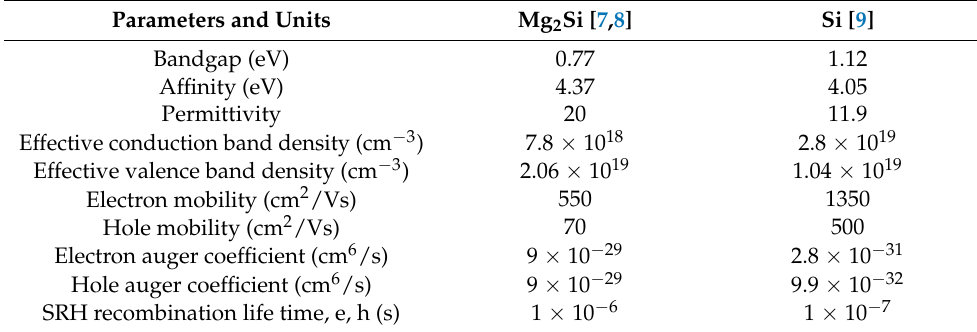
Figure 2. The structural diagram of the heterojunction PD. Table 1. The optical and electrical parameters of Mg 2 Si and Si.